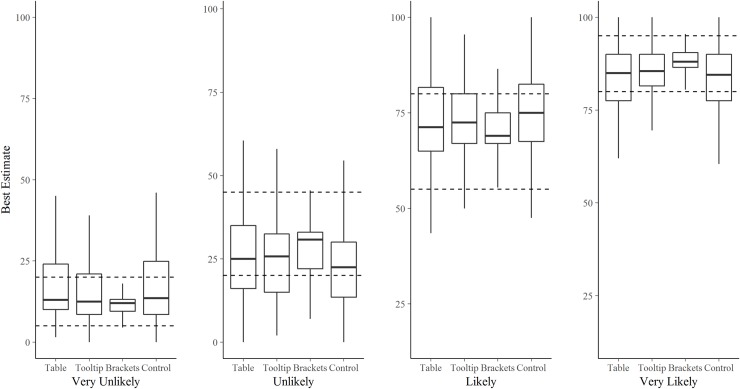
Participants’ translations of each of the four target verbal probability phrases (Very Unlikely, Unlikely, Likely, Very Likely), from words into numerical best estimates.Results are presented by condition. Each boxplot covers ~95% of the distribution. Boxes indicate the central 50% of judgements, the midpoint lines within boxes show the median. Dashed lines represent the ICD 203 guidelines for those target phrases.